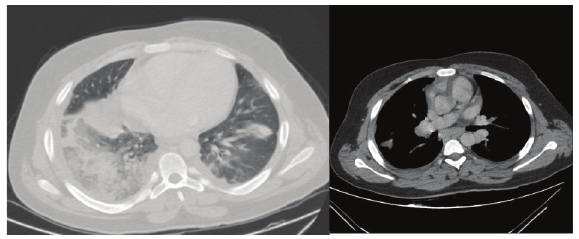
Figure 1: Consolidation areas in the lower lobe of right lung, upper- lower lobe of left lung, and lingula were observed in first drawn contrast enhanced computed tomography.